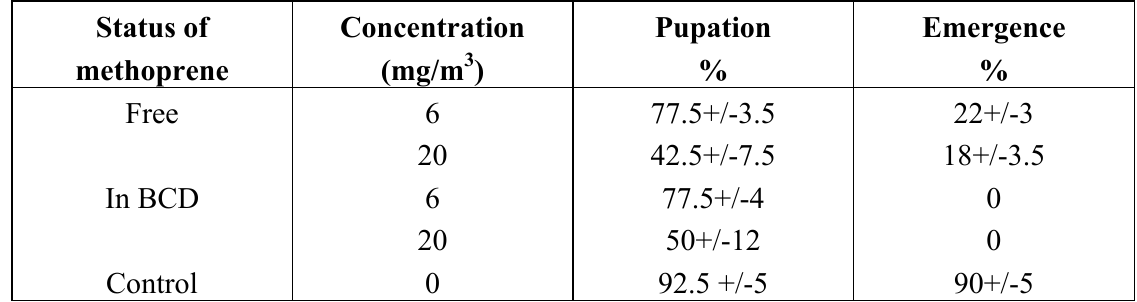
Table 4. Effect of methoprene included in a smoke releasing formulation on the larvae of Musca